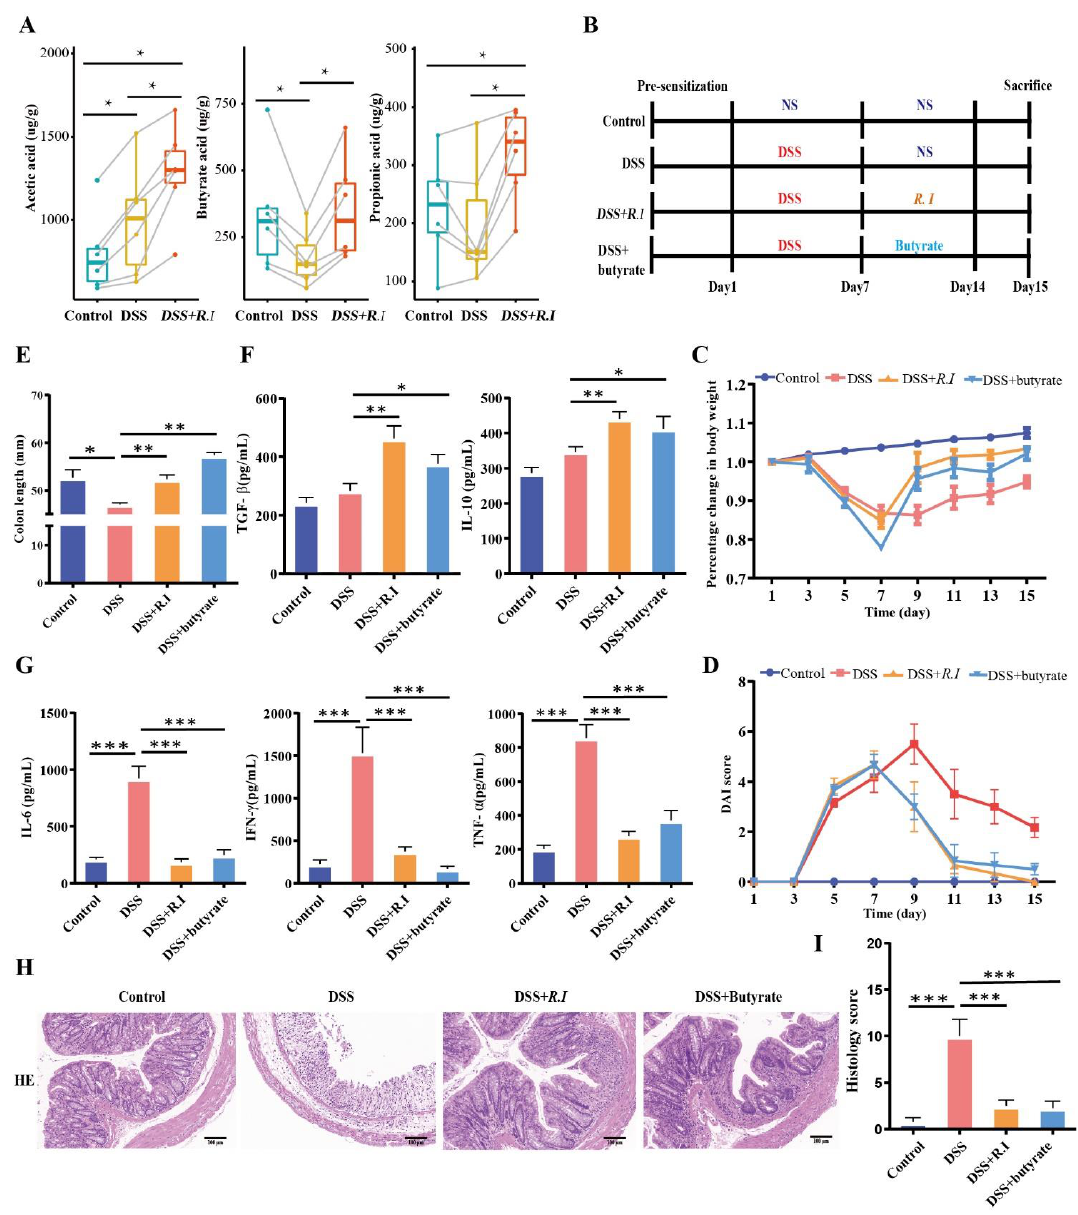
Figure 4. R. intestinalis inhibits the inflammatory progression of UC through its metabolite butyrate. ( A ) SCFA profiling in the control, DSS, DSS + R. I, and DSS + butyrate groups. ( B ) Schematic testing of the effect of R. intestinalis and butyrate on colitis mice generated by DSS. ( C ) The percent change in body weights of mice in the three groups is plotted and presented. ( D ) The DAI scores of the control, DSS, DSS + R. I, and DSS + butyrate groups treated mice. ( E ) The colon length of the three groups on Day 15. ( F , G ) Multifactor analysis of TGF- β, IL -10, IL-6, IFN- γ, and TNF - α protein levels in the control, DSS, DSS + R. I , and DSS + butyrate groups. ( H ) Representative images of H&E staining among the three groups. ( I ) The histology score of HE staining. These data represent the mean ± SD of 3 replicates; * p < 0.05, ** p < 0.01, and *** p < 0.001.